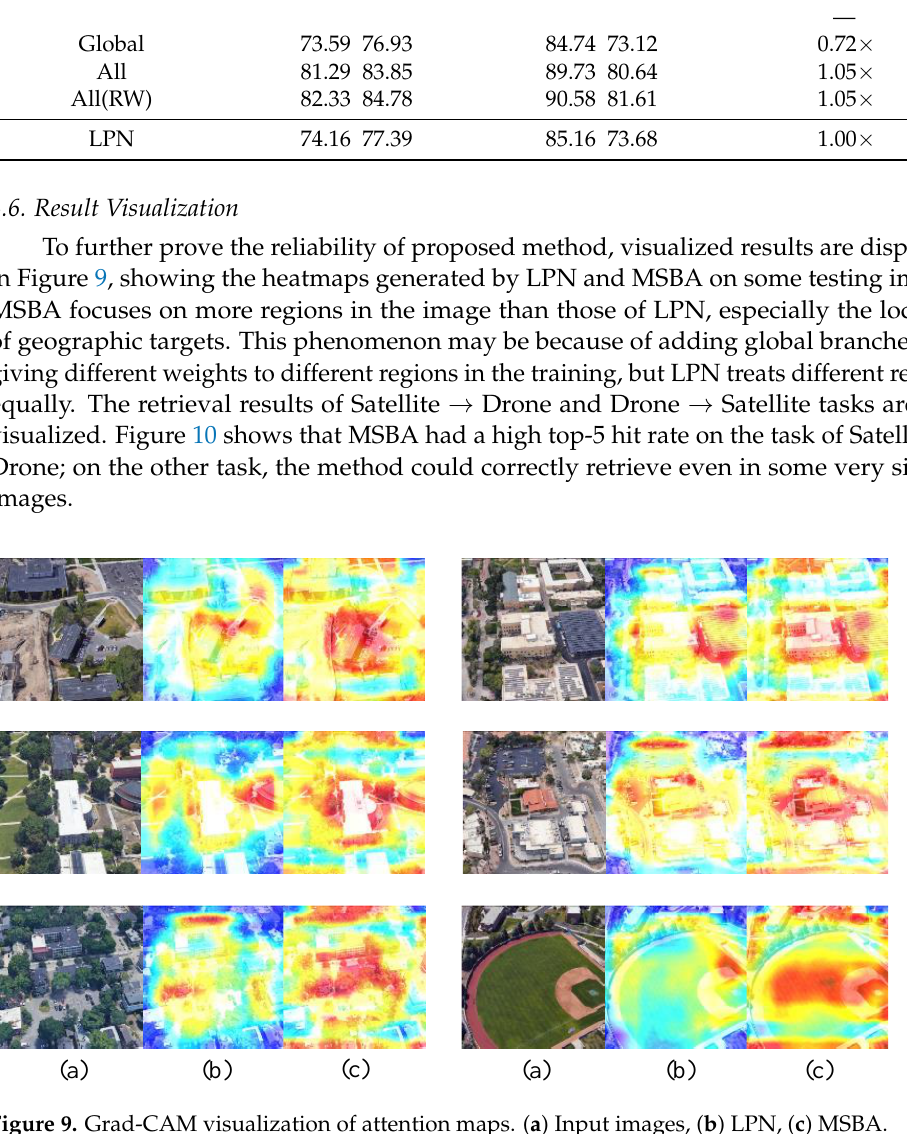
Figure 9. Grad-CAM visualization of attention maps. ( a ) Input images, ( b ) LPN, ( c ) MSBA.